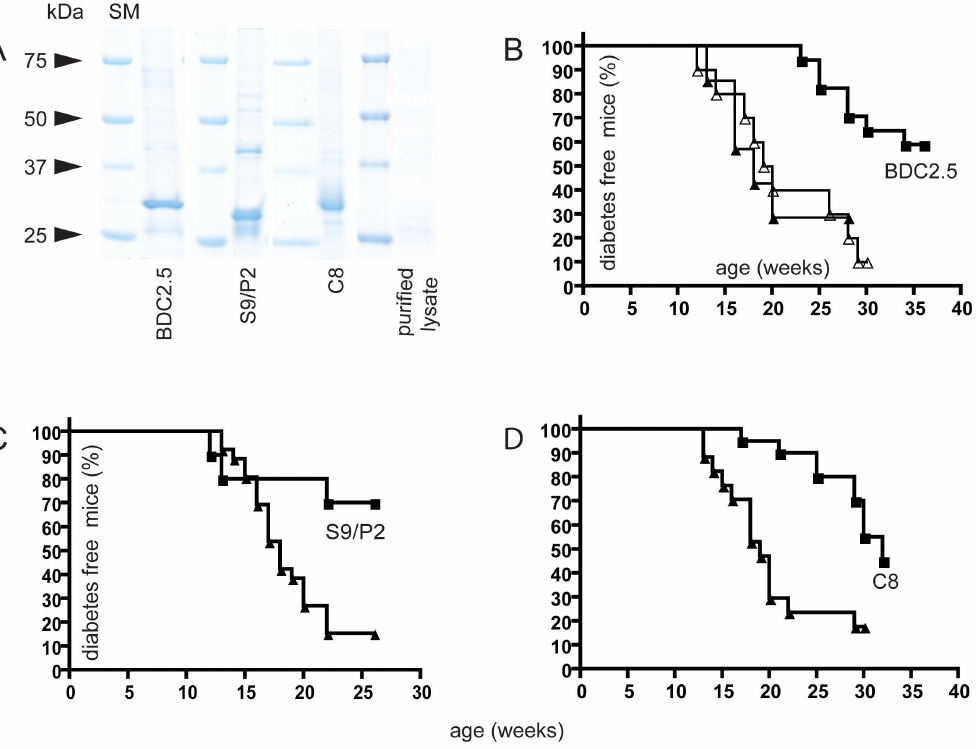
Figure 9. Effects in NOD mice. To investigate the effects of anti-idiotypic vaccination on the development of diabetes in NOD mice, recombinant scFvs were purified from bacterial lysates ( E. coli strain HB2151) by Cobalt-NTA metal chelate affinity chromatography and analyzed by a Coomassie- stained SDS-PAGE gel (SM=size marker). In addition a lysate of non-transformed bacteria was produced and purified via metal chelate affinity chromatography as if it contained the recombinant protein (A). This preparation in alum served as one control, the other was alum alone. As shown in B, vaccination of NOD mice at 4 and 7 weeks of age with the purified control lysate (open triangles, n=10) had no significant effect on diabetes onset as compared to vaccination with alum alone (closed triangles, n=7). In contrast, vaccination with BDC2.5 TscFv (0.2 mg/kg; n=17; squares) significantly delayed diabetes onset (P , 0.001; logrank test). NOD mice vaccinated at 4 weeks and at 7 weeks of age with TscFv S9/P2 (0.2 mg/kg i.p.; n=10; squares) exhibited a similar delay in diabetes onset as compared to control-vaccinated mice (alum, triangles, n=26) (P , 0.05) (C). Diabetes was also delayed by vaccination (at 4 weeks and at 7 weeks of age) with BscFv C8 (1.5 mg/kg i.p.; n=17; squares) as compared to control vaccination (alum, triangles, n=20, P , 0.005) (D). Postponing initial vaccination with C8 to 10 weeks of age rendered the treatment